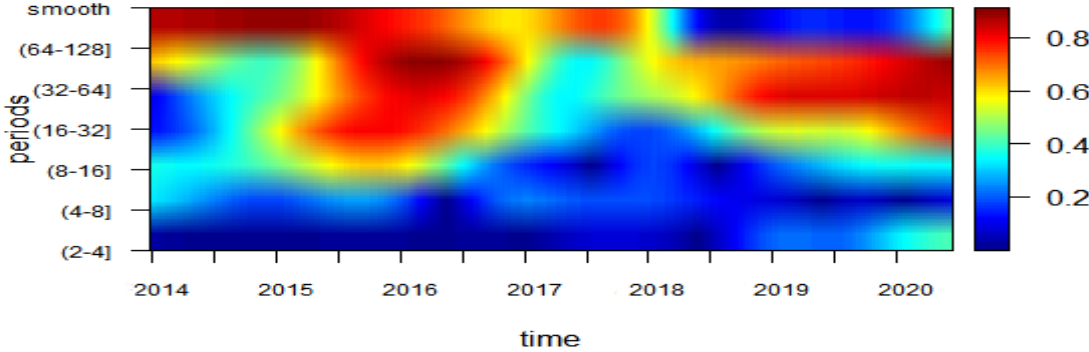
Figure 2. Wavelet multiple correlations between the S&P 500 and N225 stock market returns.